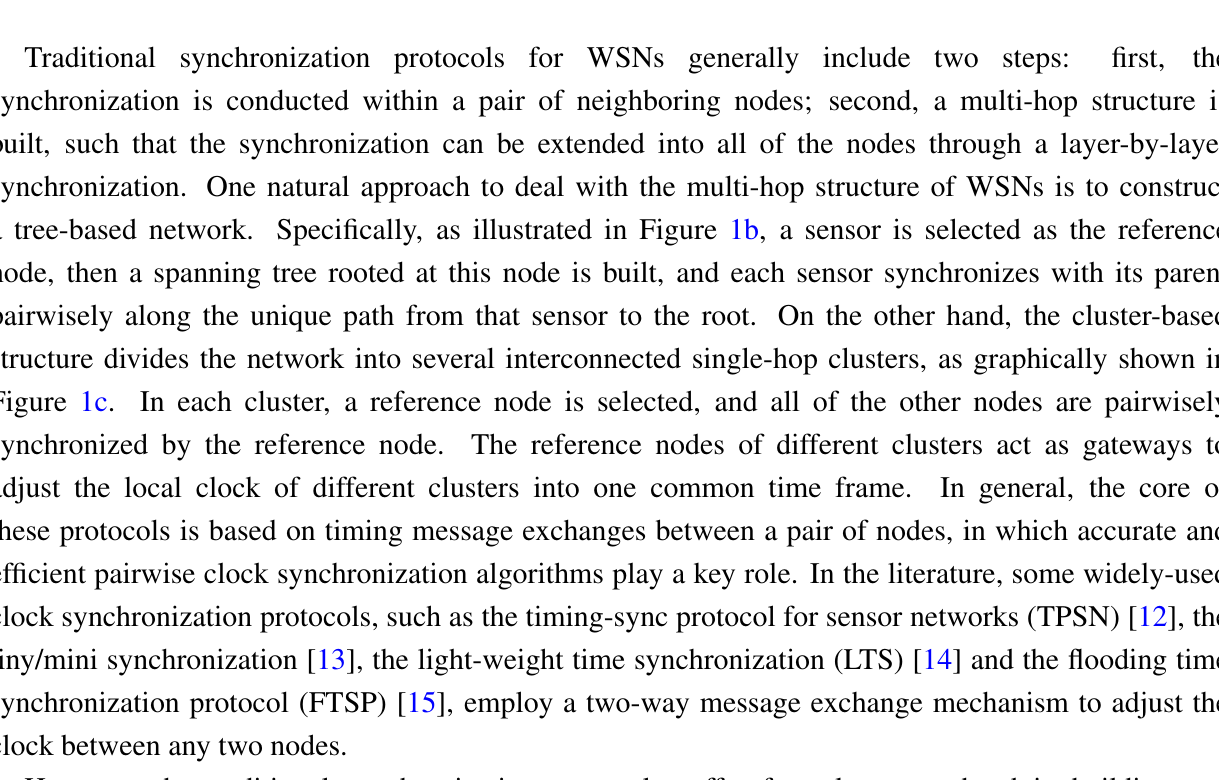
Figure 1. Network topology for different synchronization